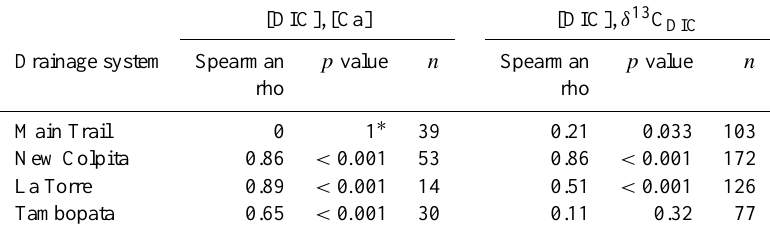
Table 3. Spearman rho, p values and sample sizes ( n ) for correlations that indicate carbonate weathering contributions. [DIC], [Ca] [DIC], δ 13 C DIC Drainage system Spearman p value n Spearman p value n rho rho Main Trail 0 1 ∗ 39 0.21 0.033 103 New Colpita 0.86 < 0 . 001 53 0.86 < 0 . 001 172 La Torre 0.89 < 0 .